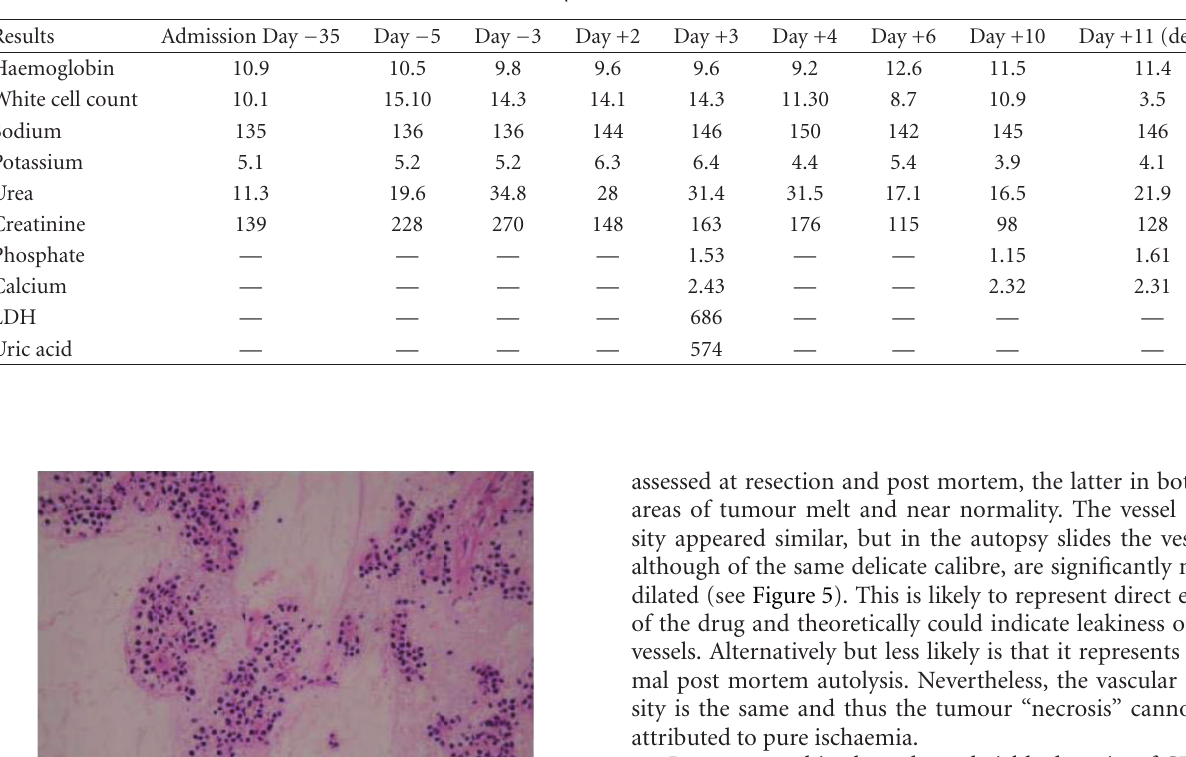
Table 1: Tabulation of renal function over a 47-day period starting from 35 days prior to treatment with imatinib to 11 days post treatment. LDH = lactate dehydrogenase. Normal ranges: haemoglobin (13.0–18.0 g/dL), white cell count (4.0–11.5E9/l), sodium (135– 145 mmol/L), potassium (3.5–5.3 mmol/L), urea (1–6.5 mmol/L), creatinine (60–120 µ mol/L), phosphate (0.8–1.4 mmol/L), corrected cal-